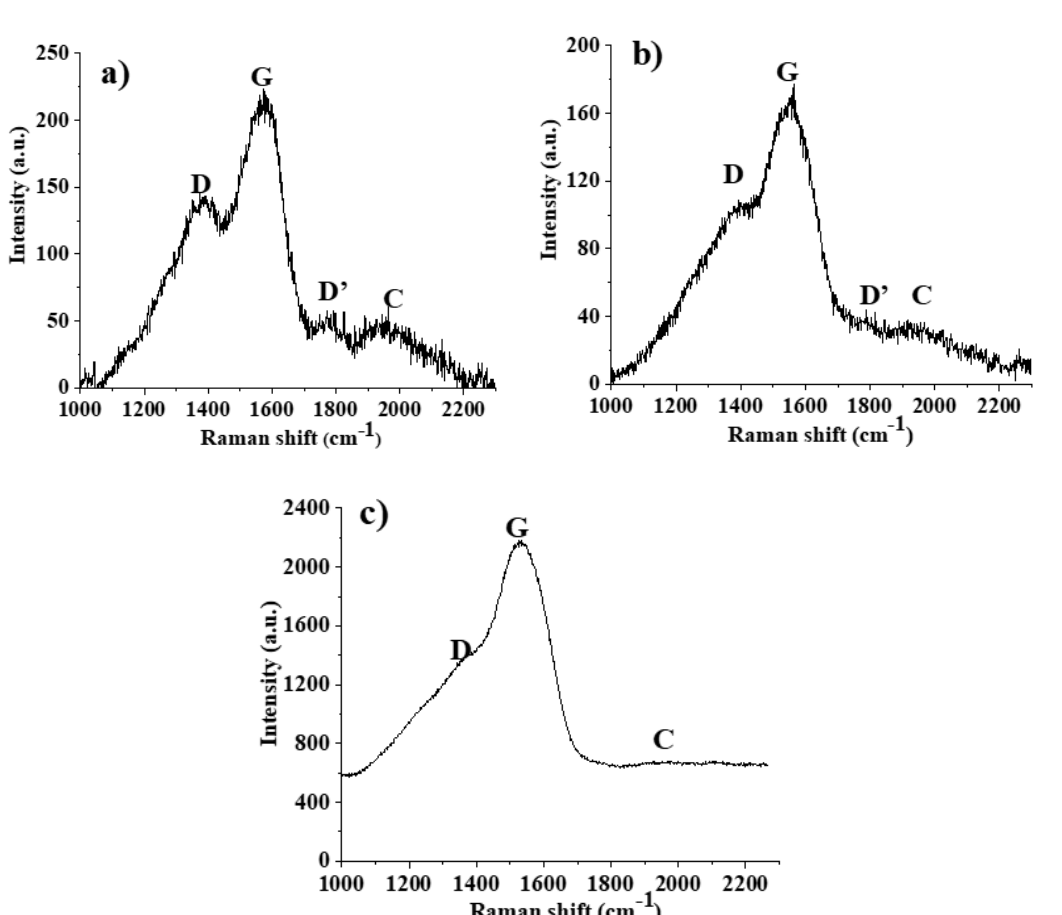
Figure 4. Micro-raman spectra of carbon thin films: ( a ) C15, ( b ) C60, and ( c ) C100.